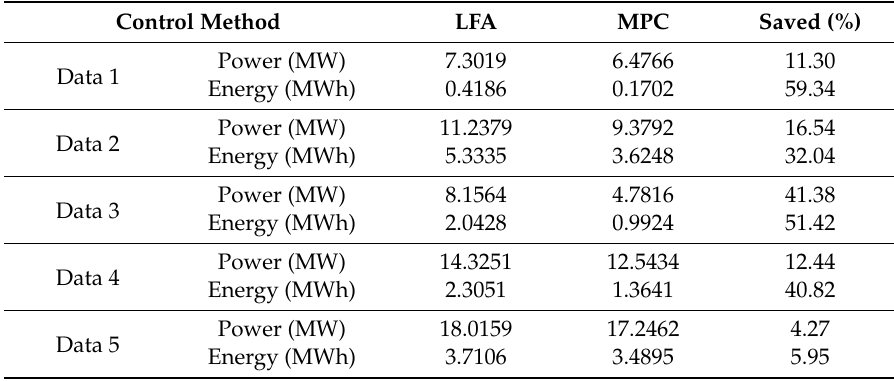
Table 4. Comparison of power and energy requirements for different